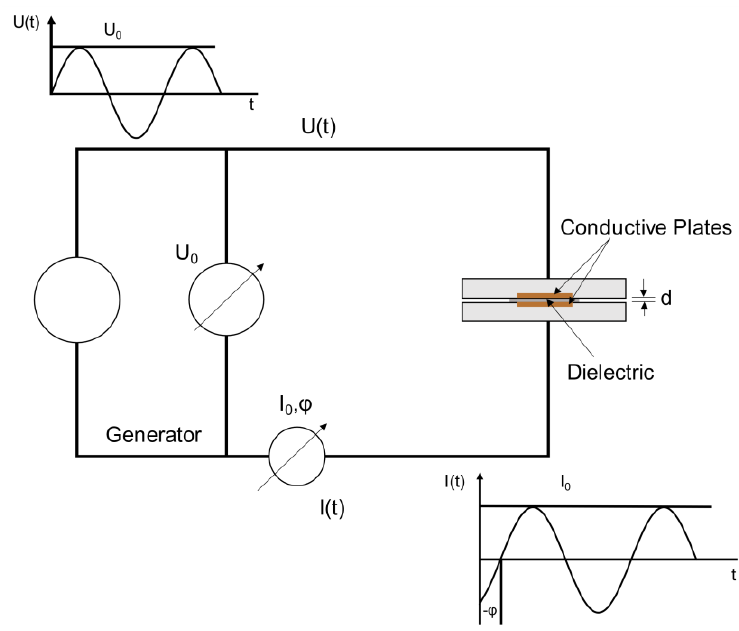
Figure 5. Principle of dielectric measurement [26].